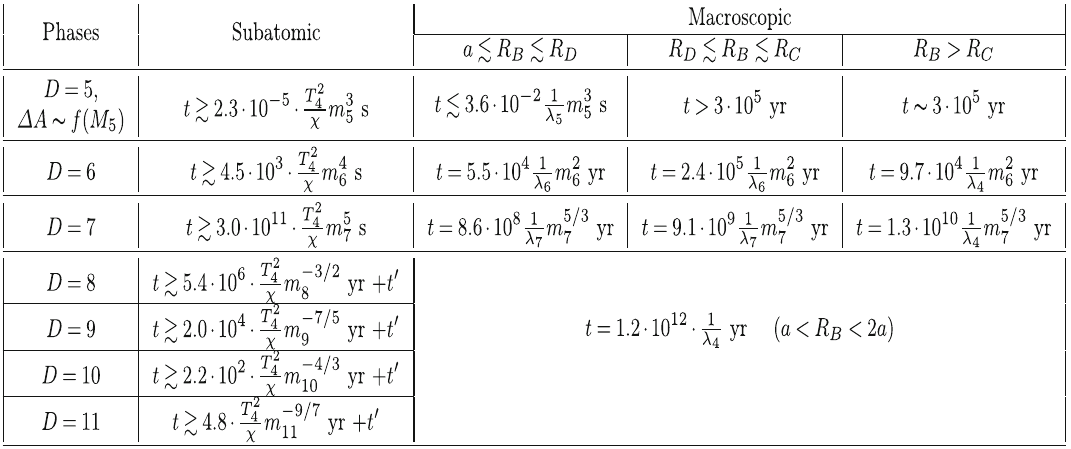
Table 1 Accretion times of the stable micro black holes inside the Earth divided into subatomic (capture radius smaller than a = 1 Å) and macroscopic phases. The macroscopic phase is divided into three, divi-